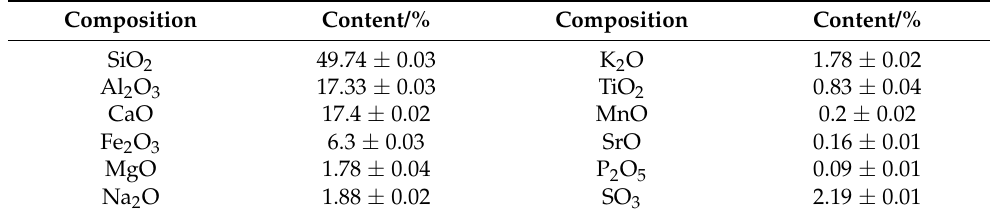
Table 3. Composition of the ash of raw coal.